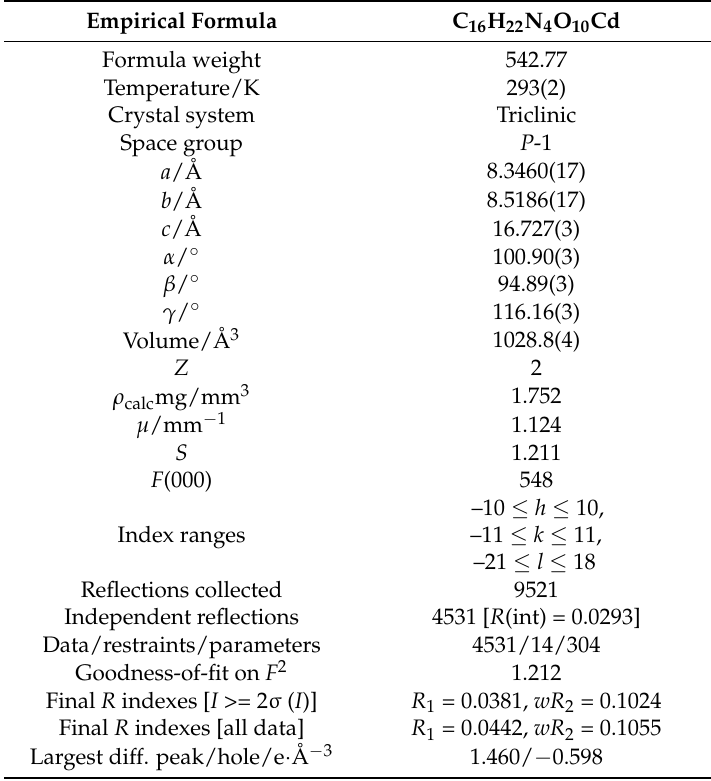
Table 2. Crystallographic data and structure refinement for [{CdL 2 (H 2 O)} · (H 2 O) 3 ] n